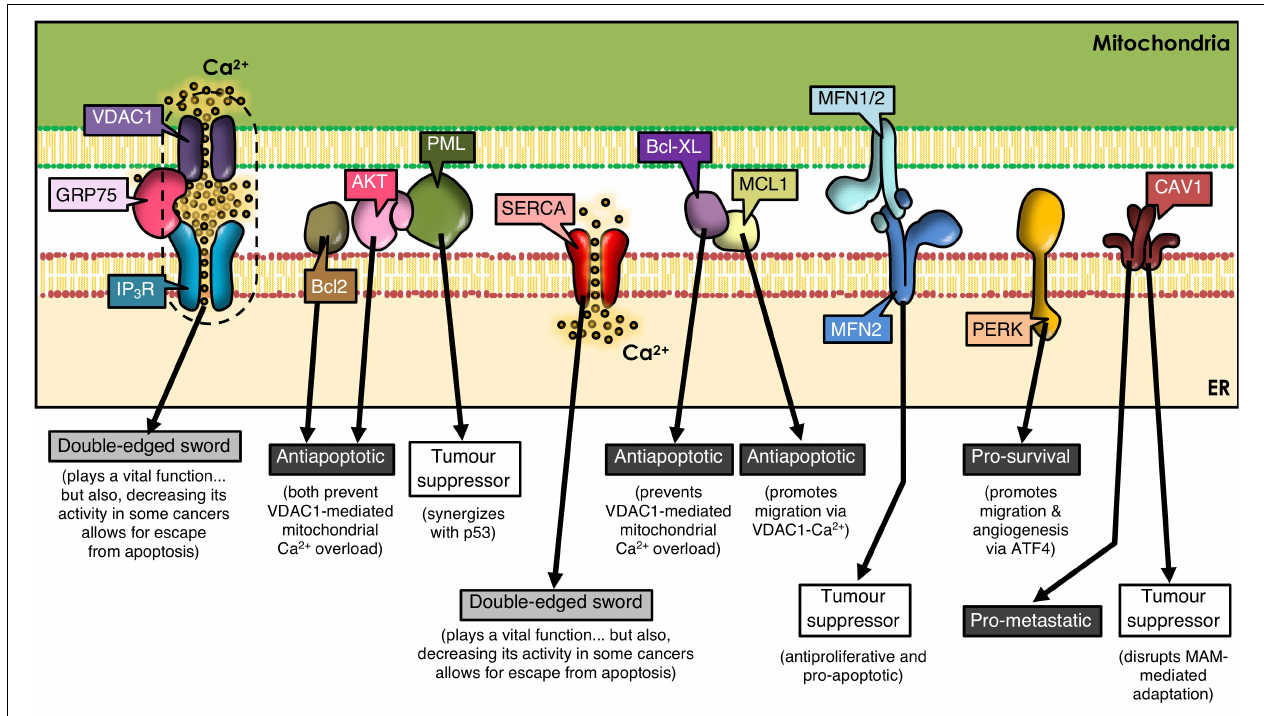
FIGURE 1 | ER-mitochondria contacts and cancer development. Many proteins present at MAMs determine the outcome of tumorigenesis. VDAC1, GRP75, IP 3 R, and SERCA play a dual role, as they are essential for cell viability by mediating ER-to-mitochondria Ca 2 + transfer; but, paradoxically, a decrease in their function prevents apoptosis in some cancer types. Many other MAM-residing proteins regulate IP 3 R-VDAC1 interplay, tilting the balance to one side or the other. Additional subsets of proteins are shown that either reside in or translocate to MAMs, thereby controlling signaling networks that modulate cell fate.